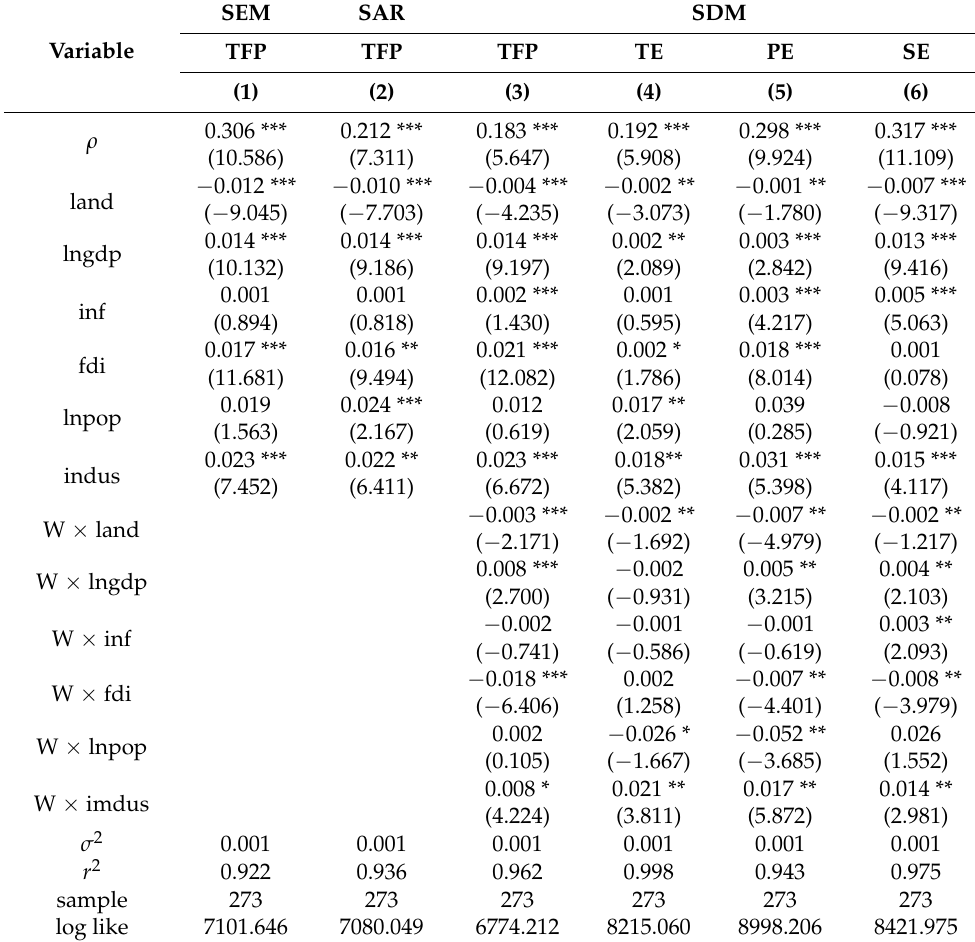
Table 5. Results of spatial econometric estimation at the national